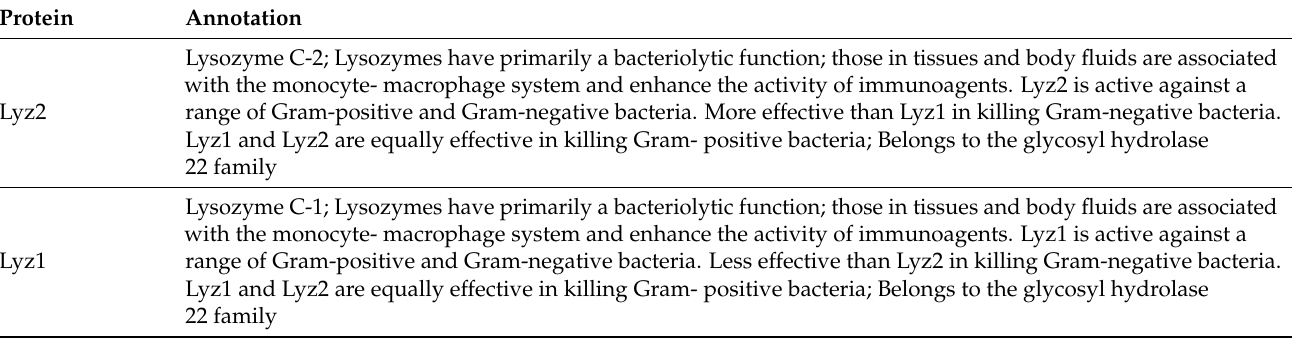
Table 5. Functional annotation of Lyz2 protein association network.